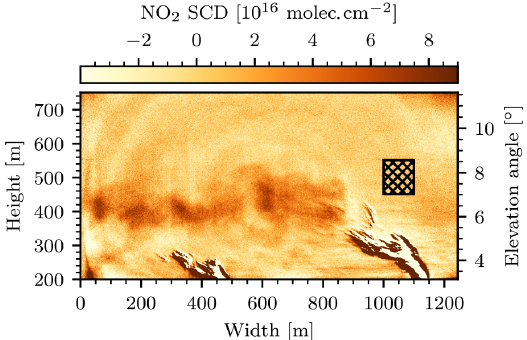
Figure 14. The first image of the measurement. For this image six individual images were averaged, which amounts to 12s of total exposure. The center of the image shows the positive NO 2 plume signal of approximately 5 · 10 16 molec.cm − 2 . The patterned rectan- gle marks our choice for the off-plume region used to calculate the column density in the gas cell of the instrument S c , the signal offset ˜ τ 0 , and the detection limit (cid:49)S . At the point of emission (i.e., at a width of 1000m) the plume was in a fully condensed phase, which, due to optical misalignment of the cameras of the instrument to- wards the corners of the FOV, generates strong false signals.